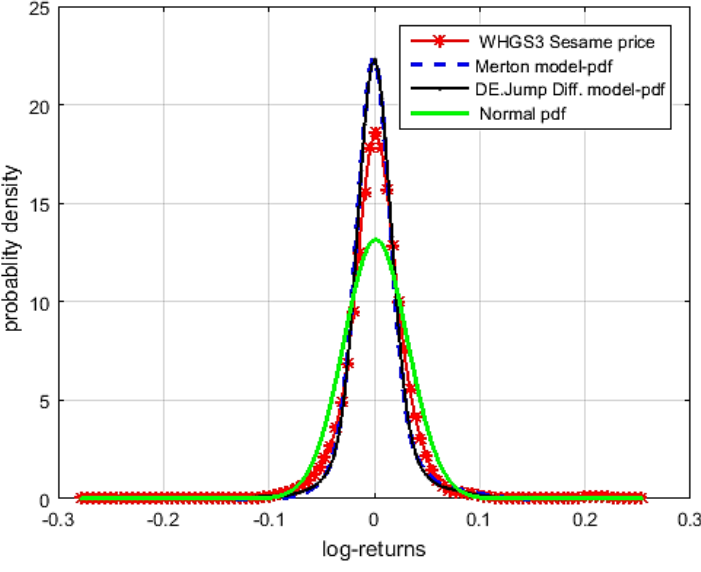
Figure 9. The probability densities of the models fitted with the log-return of WHGS3